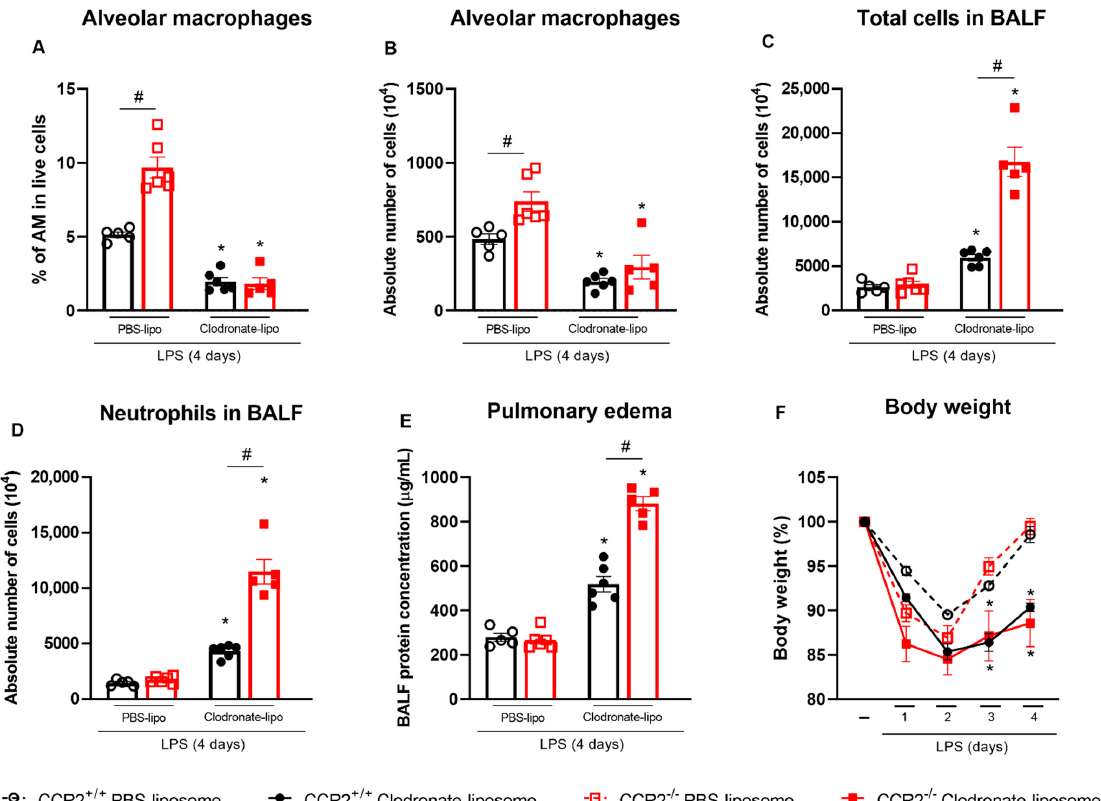
Figure 7. Depletion of AM leads to worsened inflammation especially in CCR2 − / − mice. CCR2 +/+ (black symbols) and CCR2 − / − (red symbols) C57BL/6 mice were treated intranasally with liposomes loaded with clodronate or PBS. One day later, they were challenged with LPS (12.5 µg/mouse) and after 4 days mice were euthanized. Percentage ( A ) and absolute numbers ( B ) of alveolar macro- phages (CD45 + CD11c + SiglecF + cells) isolated from the lungs and BALF were quantified by flow cy- tometry. Total leukocytes ( C ) and neutrophils ( D ) in BALF were counted microscopically. Pulmo- nary edema was quantified based on the protein concentration in the BALF ( E ). Changes in body weight ( F ) were calculated with the weight before challenge (day 0) as reference. Data are shown as mean ± SEM. Each symbol represents data of an individual mouse. * p < 0.05 when compared with the respective group treated with PBS-loaded liposomes. # p < 0.05 when comparing wild type and knockout group treated with clodronate-loaded liposomes. Mann–Whitney U test was used. n = 5– 6.